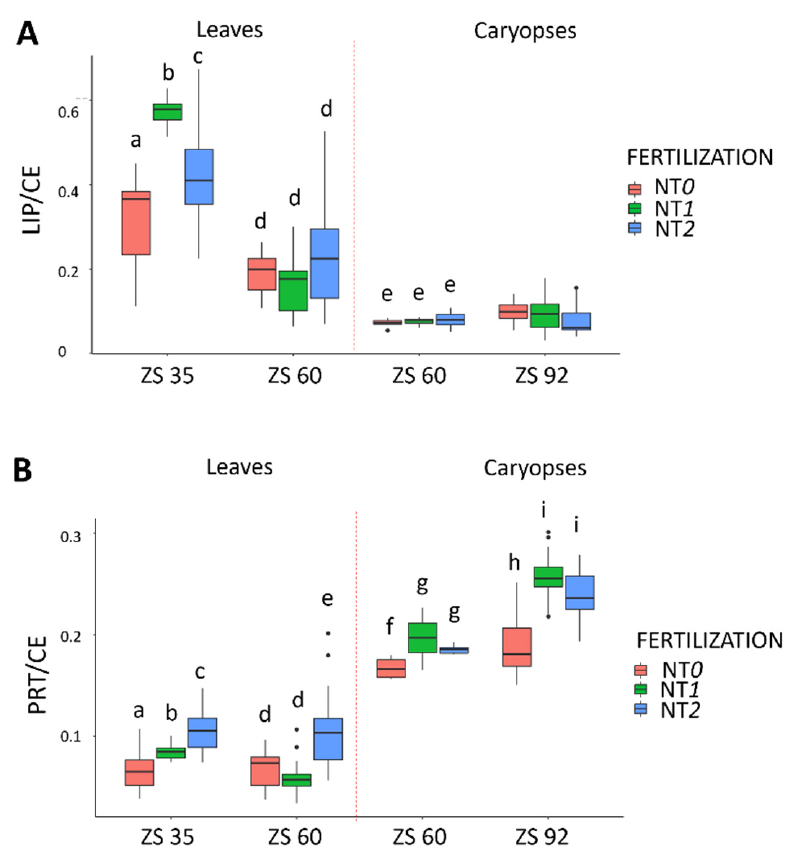
Figure 8. Statistical analysis of the biochemical composition of durum wheat leaves and caryopses collected on no-tillage soil at different sampling timepoints as a consequence of various nitrogen fertilization levels. The box plot shows the differences in LIP ( A ) and PRT ( B ) content with respect to cellulose (CE). No-tillage soil, fertilized with 90 kg N ha − 1 (NT 1 ) and 180 kg N ha − 1 (NT 2 ), was used. The center line marks the median; edges indicate the 25th and 75th percentiles; vertical lines indicate the 5th and 95th percentiles; black points indicate the potential outliers. Different letters above box charts indicate a statistically significant difference among groups. Statistical significance was set at p < 0.05.